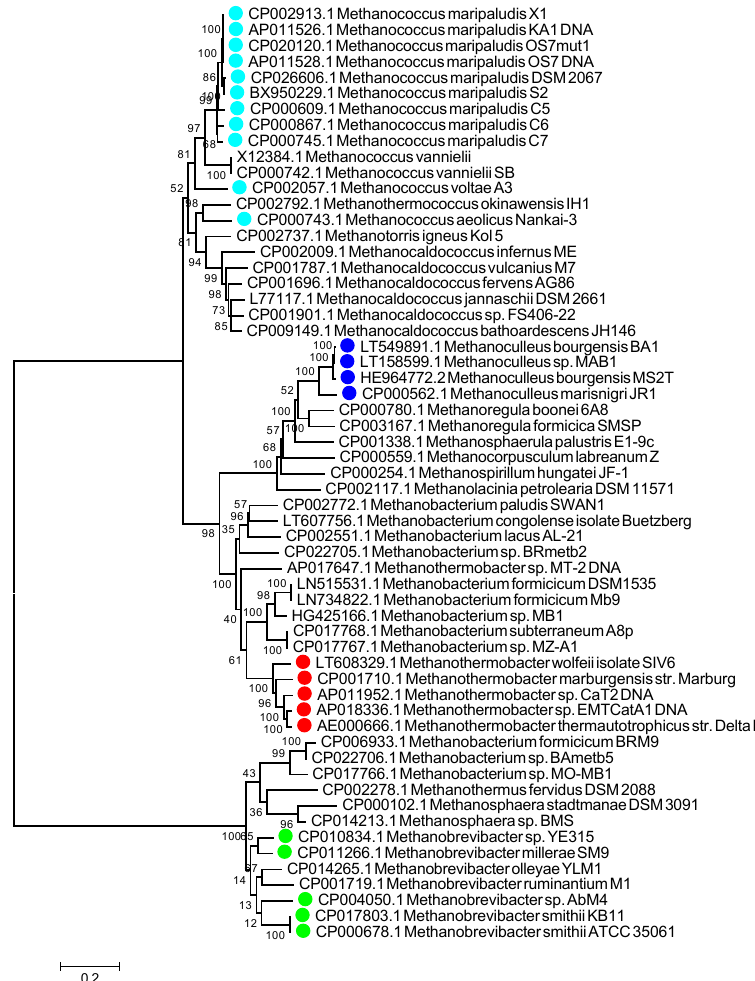
Figure 4. Specificity of LAMP primer sets for targeted genera within the methanogenic archaea. Evolutionary relationships of elongation factor 2 (aEF-2) genes within hydrogenotrophic methanogens were conducted in MEGA7 and inferred using neighbour-joining. Evolutionary distances were computed using the Jukes–Cantor method as number of base substitutions per site. The analysis used 59 nucleotide sequences. All positions containing gaps and missing data were eliminated. There were a total of 1971 positions in the final dataset. An optimal tree with sum of branch length = 6.51376856 is shown. The percentage of replicate trees in which the associated taxa clustered together in the bootstrap test (based on 500 replicates) are annotated branches. The tree is drawn to scale, with branch lengths in the same units as the evolutionary distances used to infer the phylogenetic tree. LAMP primer sets predicted to target specific species are shown as coloured circles (cyan: Methanococcus ; blue: Methanoculleus , red: Methanothermobacter ; green: Methanobrevibacter ).